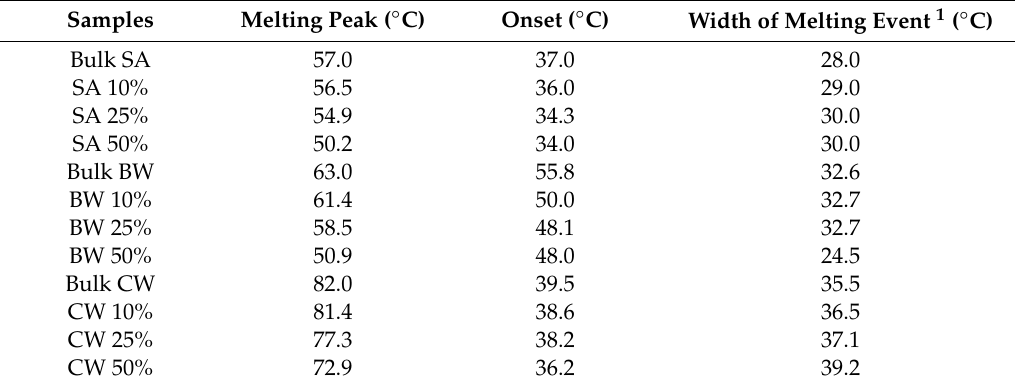
Table 3. Melting peak, onset temperature and width of the melting event of the bulk solid lipids and their binary mixtures with carvacrol obtained by di ff erential scanning calorimetry (see Table 1 for